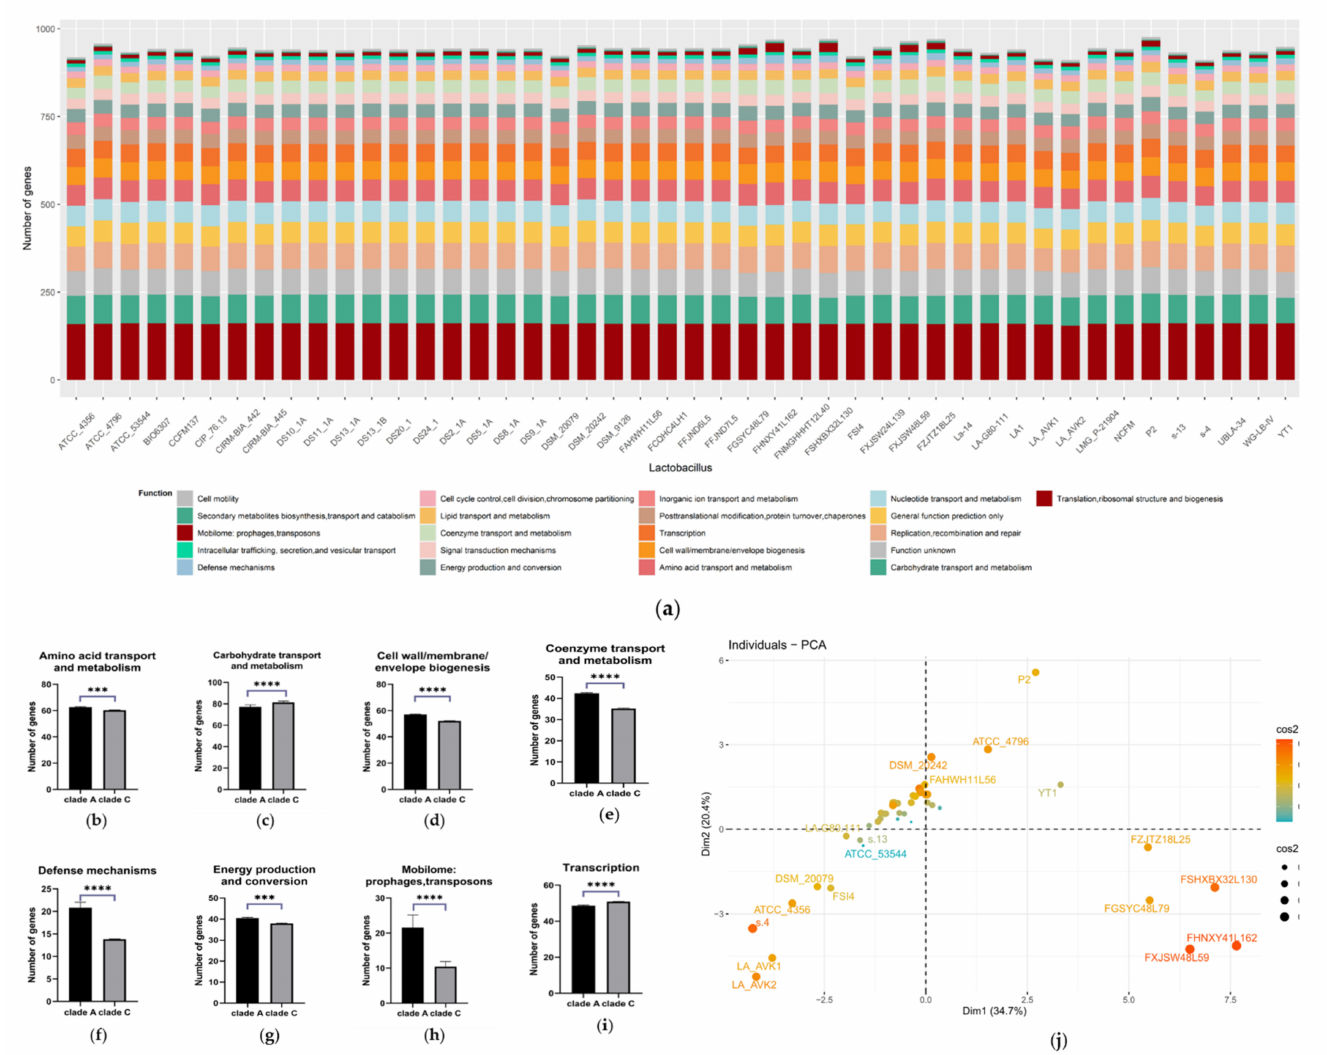
Figure 8. COG analysis of L. acidophilus . ( a ) Composition of COG function categories. ( b – i ) Number of amino acid transport genes; carbohydrate transport and metabolism genes; cell wall/membrane/envelope biogenesis genes; coenzyme transport genes; defense mechanisms genes; energy production genes; energy production genes; mobilome (prophage and transposons) genes; transcription genes in clade A and C L. acidophilus strains. ***: p < 0.001, ****: p < 0.0001. All data are presented as mean ± SEM. ( j ) PCA analysis of composition of COG function categories in different L. acidophilus